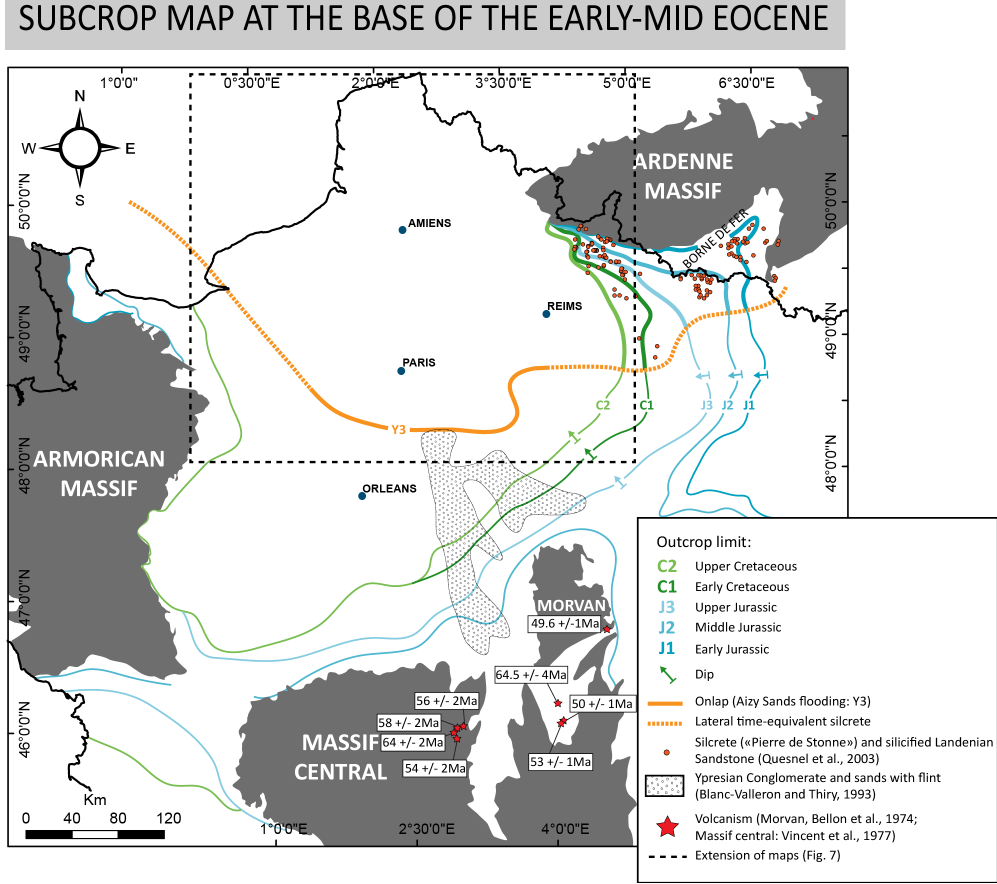
Figure 6. The uppermost Cretaceous–Palaeocene deformations of the Paris Basin. Geometrical relationship between Palaeocene–Lower Eocene sediments and tilted Jurassic to late Cretaceous sedimentary